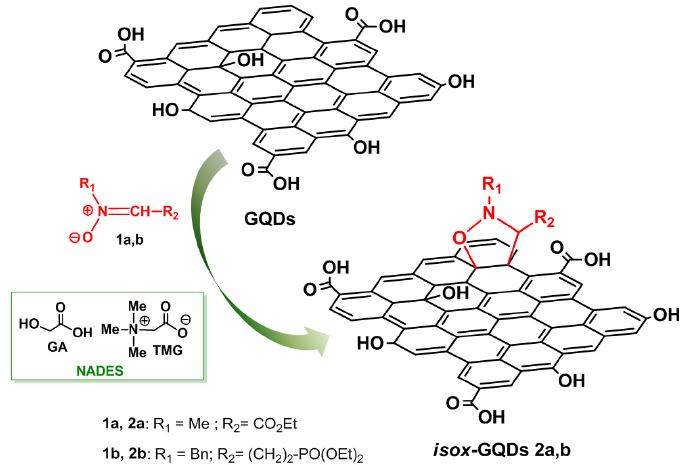
Figure 1. Eco-friendly synthesis of isox -graphene quantum dots (GQDs) 2a,b by 1,3-DCA reactions in natural deep eutectic solvent (NADES) medium.